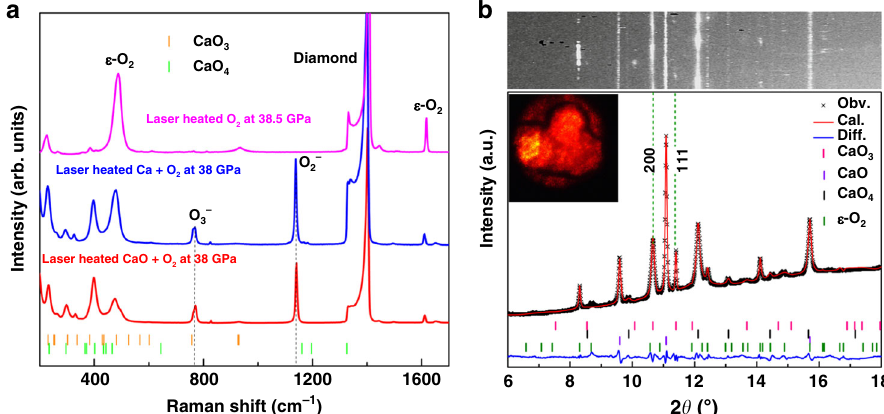
Fig. 2 Raman spectra and X-ray diffraction pattern of CaO x . a Raman spectra of Ca – O compounds at high pressure. The calculated frequencies of Raman active vibrational modes are indicated by vertical bars. b Measured powder X-ray diffraction pattern of Ca – O compounds at 35 GPa with the Rietveld method (XRD 2D image is shown at the top; inset shows a microphotographic image in the gasket hole of about 100 μ m through diamond culets). Vertical ticks correspond to the Bragg peaks of CaO 3 (pink), CaO 4 (orange), CaO (purple), and solid O 2 (wine). The X-ray wavelength is 0.4337 Å. The obtained lattice pentameters are a = 4.11 Å, c = 5.04 Å for tetragonal CaO 4 , a = 4.49Å for cubic CaO, and a = 7.13 Å, b = 4.57 Å, c = 3.74 Å, β = 110.2° for monoclinic